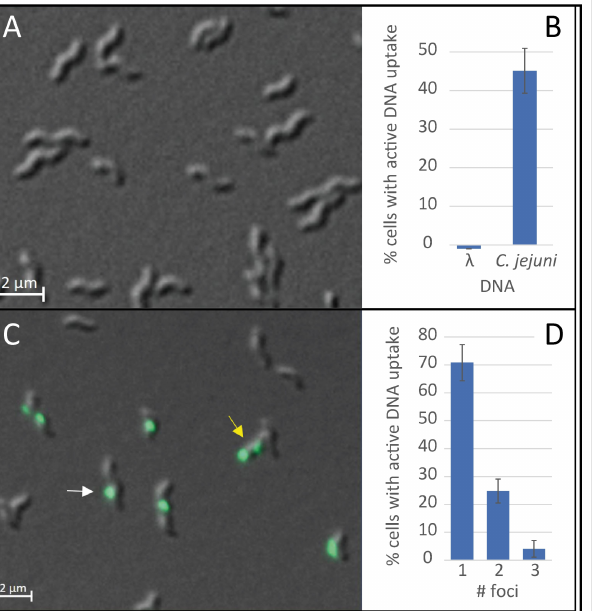
Figure 1. DNA uptake in C. jejuni BfR-CA-14430 occurs at distinct locations and is dependent on the DNA substrate. C. jejuni were incubated with fluorescently labelled DNA of the bacteriophage λ ( A ) or C. jejuni DNA ( C ) and the fraction of cells with active DNA uptake ( B ) and the distribution of number of DNA foci ( D ) after contact to C. jejuni DNA were quantified. Arrows in ( C ) indicate example bacteria with one (white) and two (yellow) DNA uptake locations. Overlay image of differential phase contrast (DIC) and Fluorescein channel. Scale bar, 2 µ m. Experiments were performed at least three times. Error bars indicate standard deviation. #,